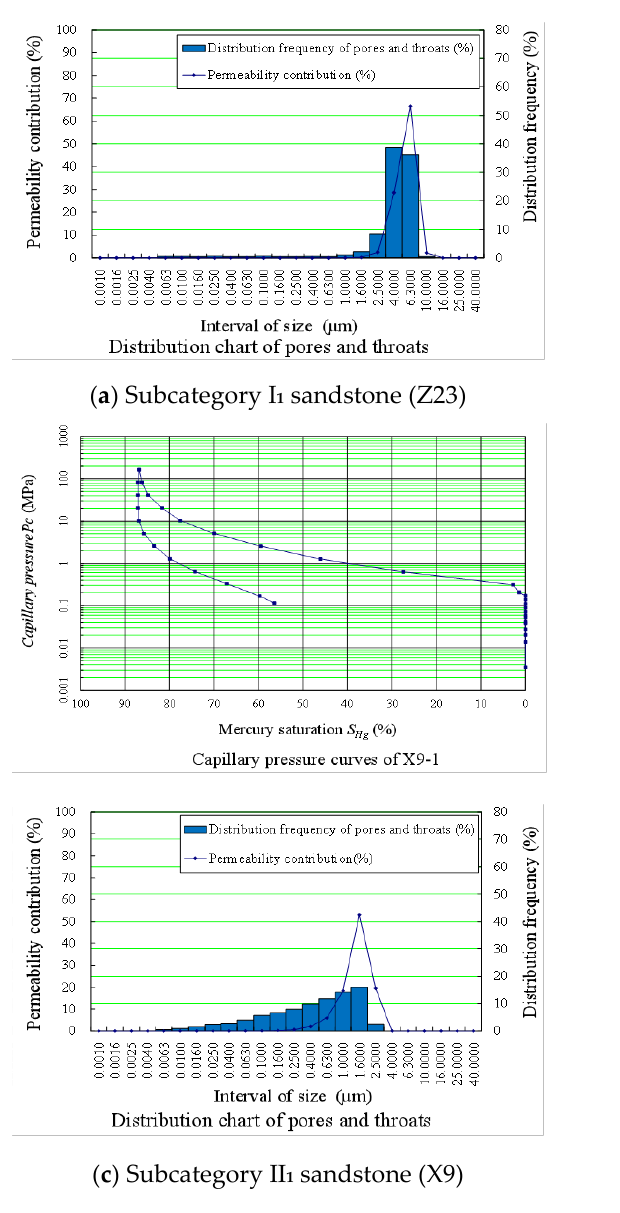
Figure 5. Comparison of the capillary pressure curves of four subcategories of sandstone showing the differences in the pores, throats and their permeability contributions among the four subcategories of sandstone: ( a ) subcategory Ι 1 sandstone showed a lower left distribution, well-sorted pore throats, coarse throat peaks at 4 to 6 µm, and a higher peak, and nearly all of the pore throats contributed to the permeability; ( b ) subcategory Ι 2 sandstone showed a slight lower left distribution, well-to-moderately sorted pore throats, coarse throat peaks at 1.6 to 4 µm, and a high peak, and most of the pore throats contributed to the permeability; ( c ) subcategory II 1 sandstone showed a slight upper right distribution, moderately to poorly sorted pore throats, coarse throat peaks at 1 to 1.6 µm, and a moderate to low peak, and approximately half of the pore throats contributed to the permeability, but with large differences; ( d ) subcategory II 2 sandstone showed an upper right distribution, poorly sorted pore throats, coarse throat peaks at 0.0063 – 0.1 µm, and a lower peak, and minute amounts of pore throats contributed to the permeability.